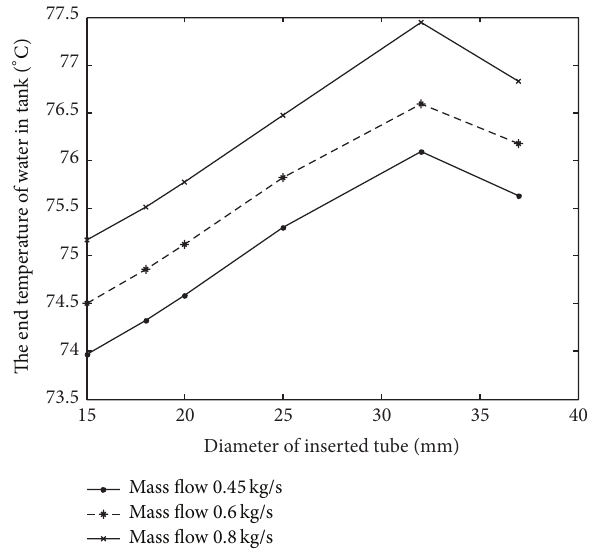
Figure 11: Water tank temperature versus inserted tube outer diameter under different mass flow